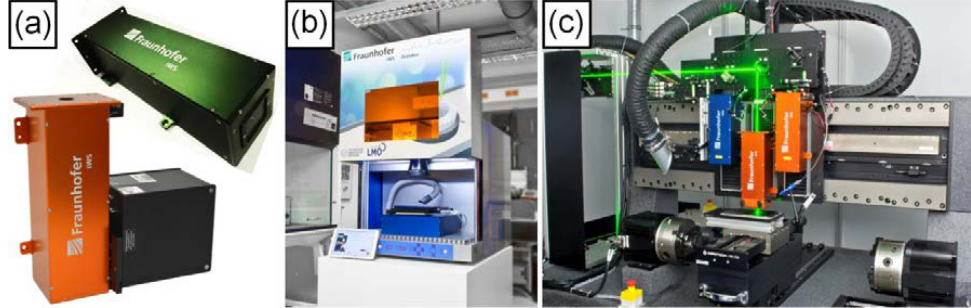
Figure 8. ( a ) High-throughput (green) and scanner-based (orange) DLIP optical heads; ( b ) DLIP-cube system with integrated scanner DLIP optics; ( c ) large area DLIP system for 2D and 3D parts (TU-Dresden, Fraunhofer IWS). The system consists of three different DLIP optics and utilizes a solid-state ps-laser.